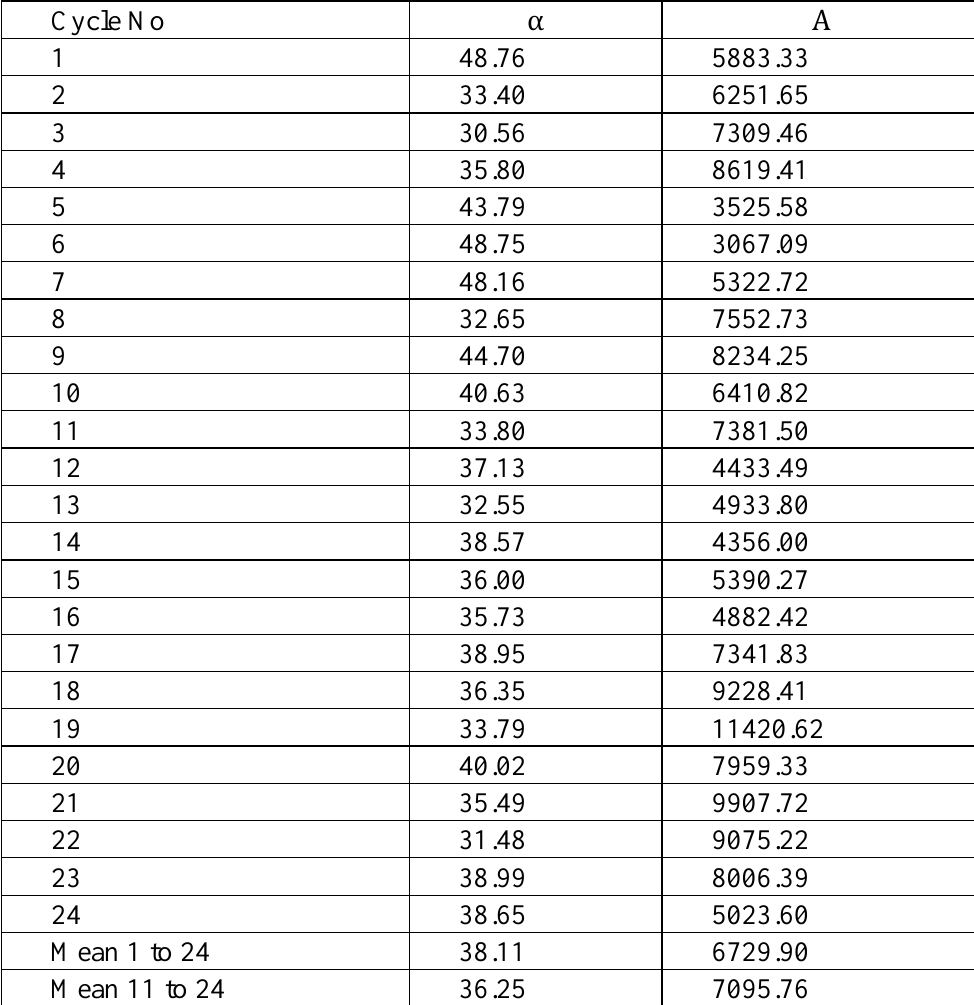
Table-1. Estimated parameters of cycles 1 to